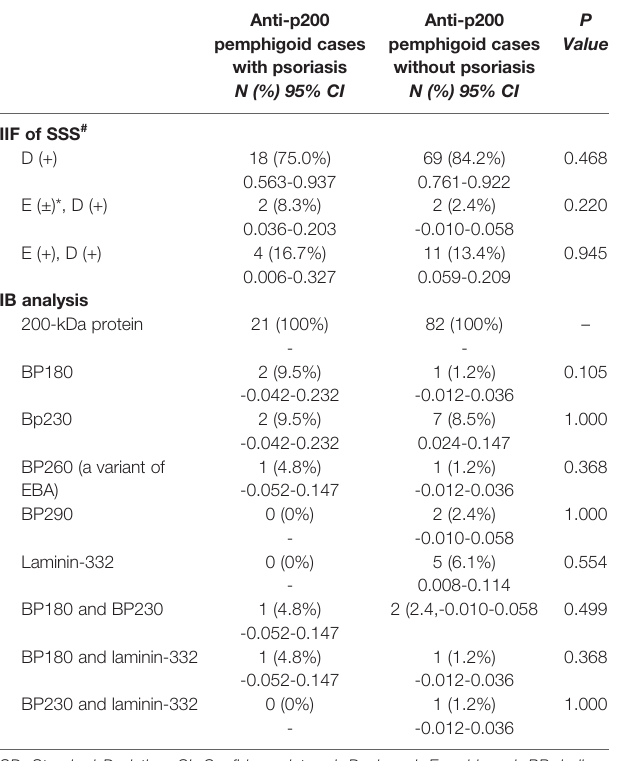
TABLE 4 | Immunopathological and serologic characterization of reported cases.